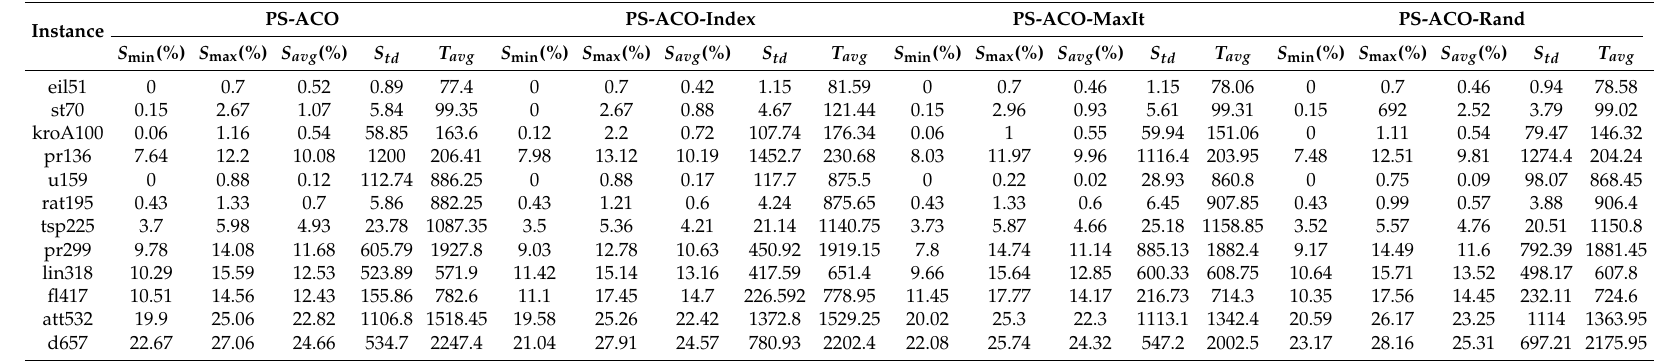
Table 4. Comparisons of PS-ACO, PS-ACO-Index, PS-ACO-MaxIt, and